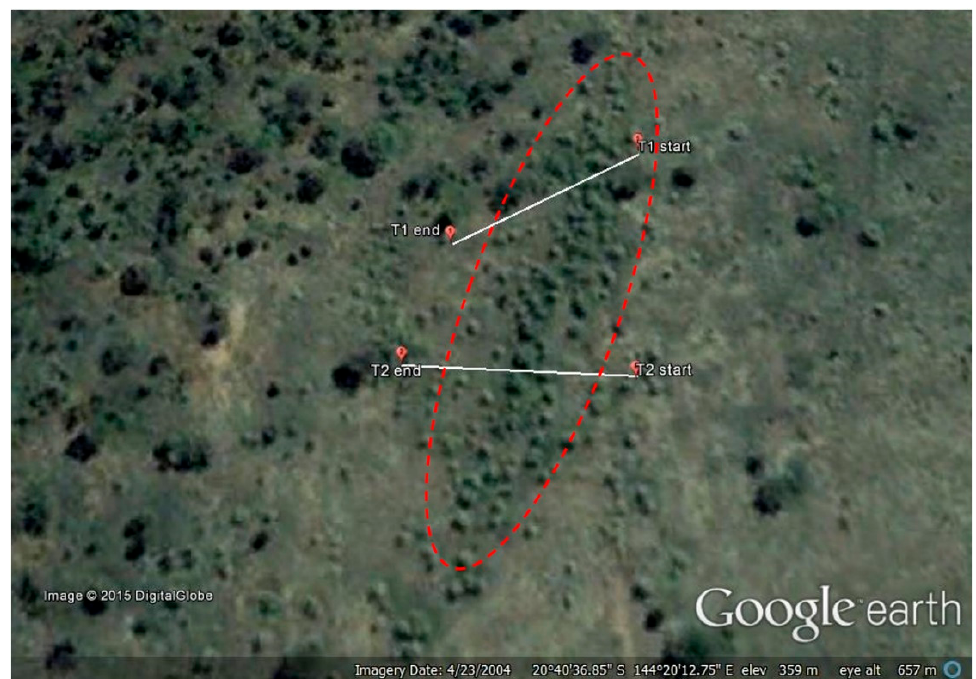
Figure 3. Satellite image of 50 m transects at Koon Kool Station one year before the trial establish- ment [15]. Red dashes outline a stand of parkinsonia plants.